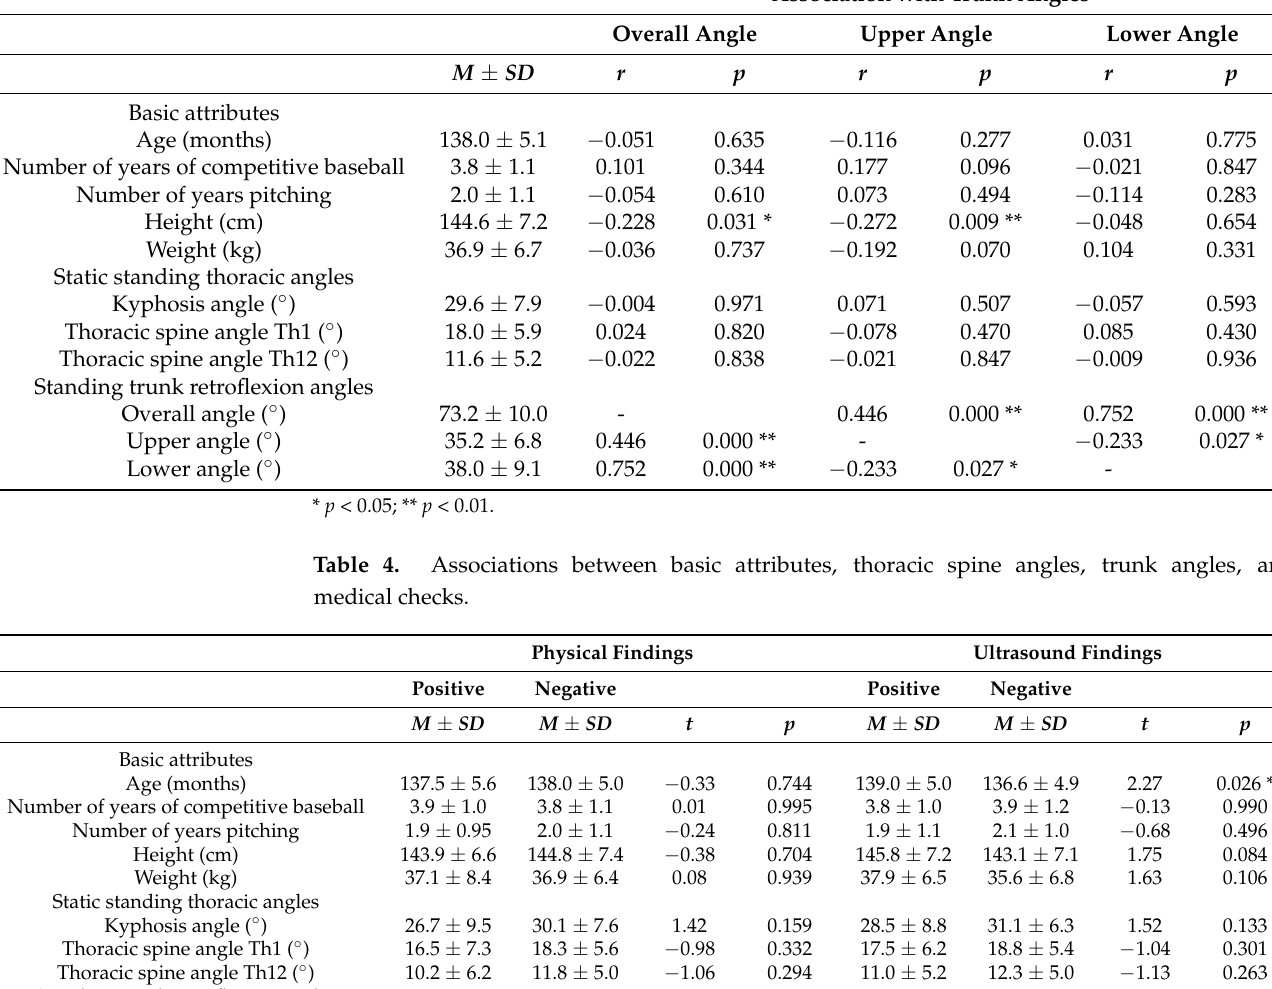
Table 3. Associations between basic attributes, thoracic spine angles, and trunk angles. Association with Trunk Angles Overall Angle Upper Angle